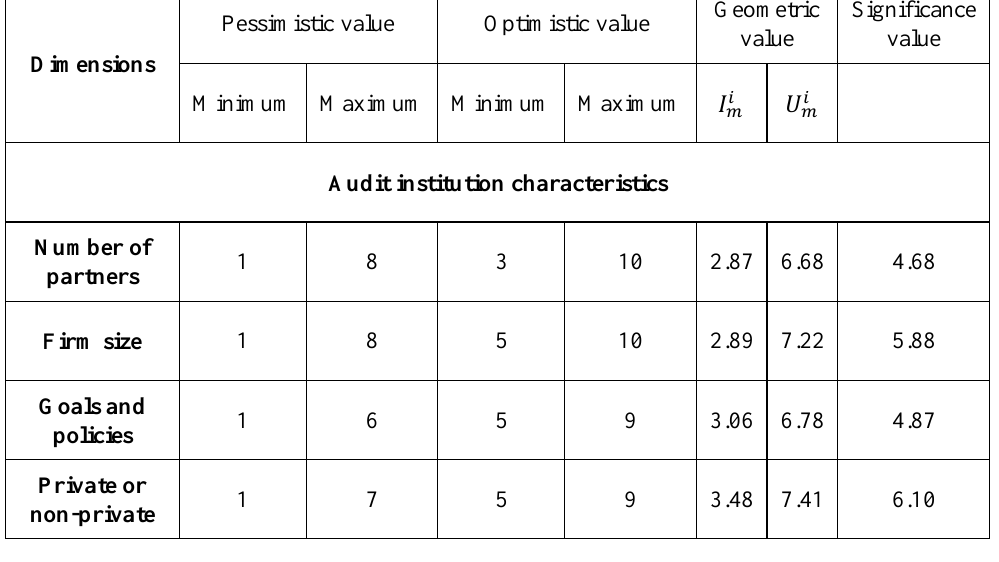
Geometric value